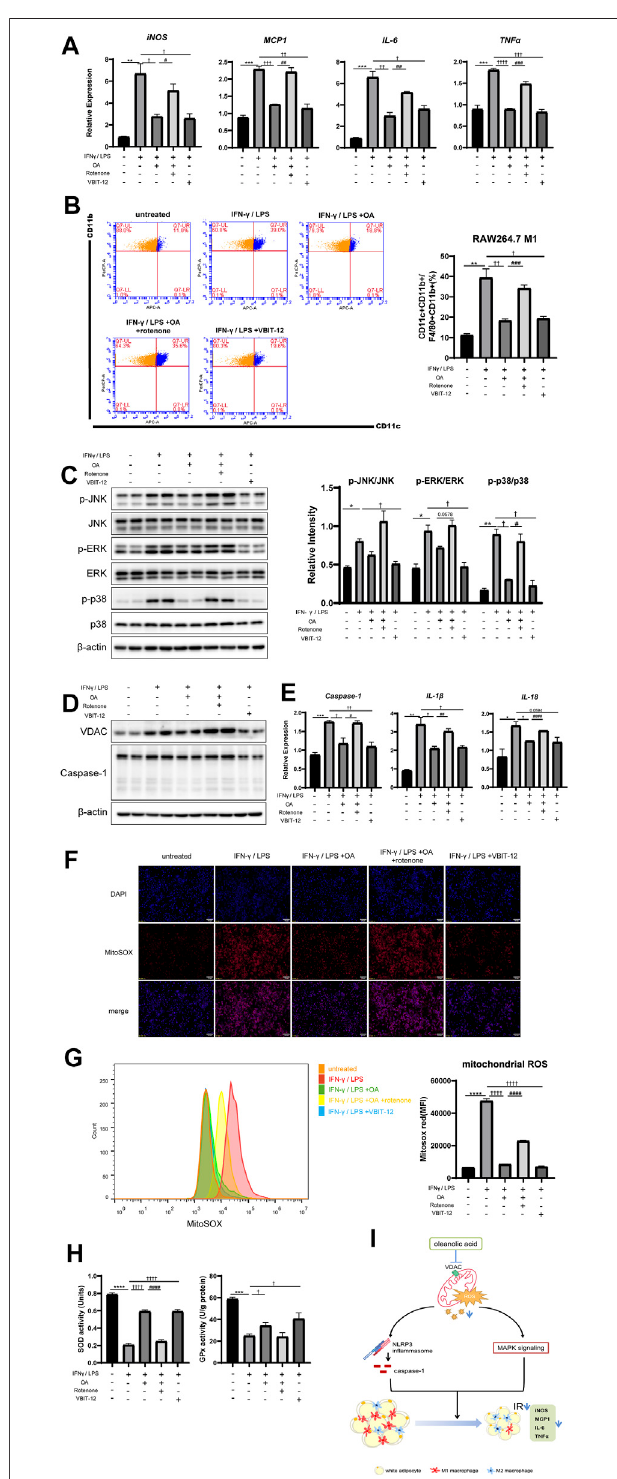
FIGURE 6 | Rotenone neutralized the anti-in fl ammatory effect of OA, while VBIT-12 showed a similar effect with OA in RAW264.7 macrophages. (A) Rotenone attenuated the inhibitory effect of OA on the expression of M1 marker mRNA in RAW264.7 macrophages induced by IFN- γ /LPS, while